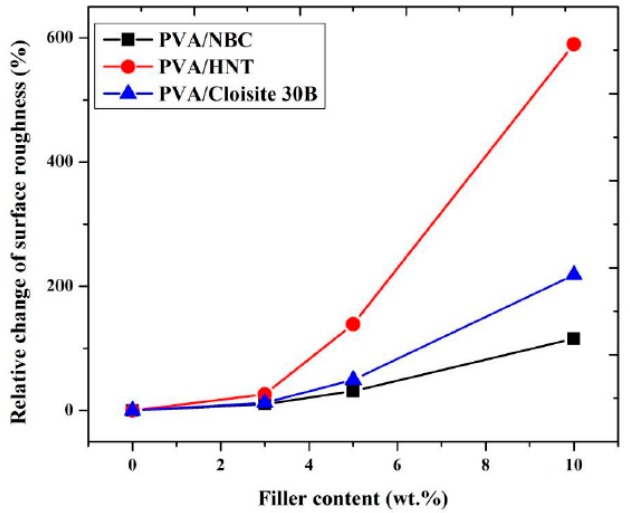
Figure 5. Relative change of surface roughness in terms of filler content in different PVA